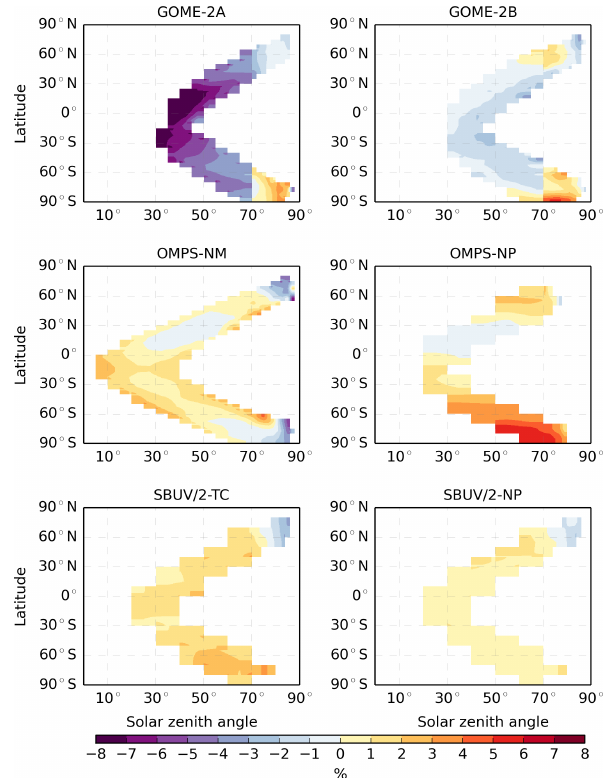
Figure 3. Same as Fig. 2 for January–February